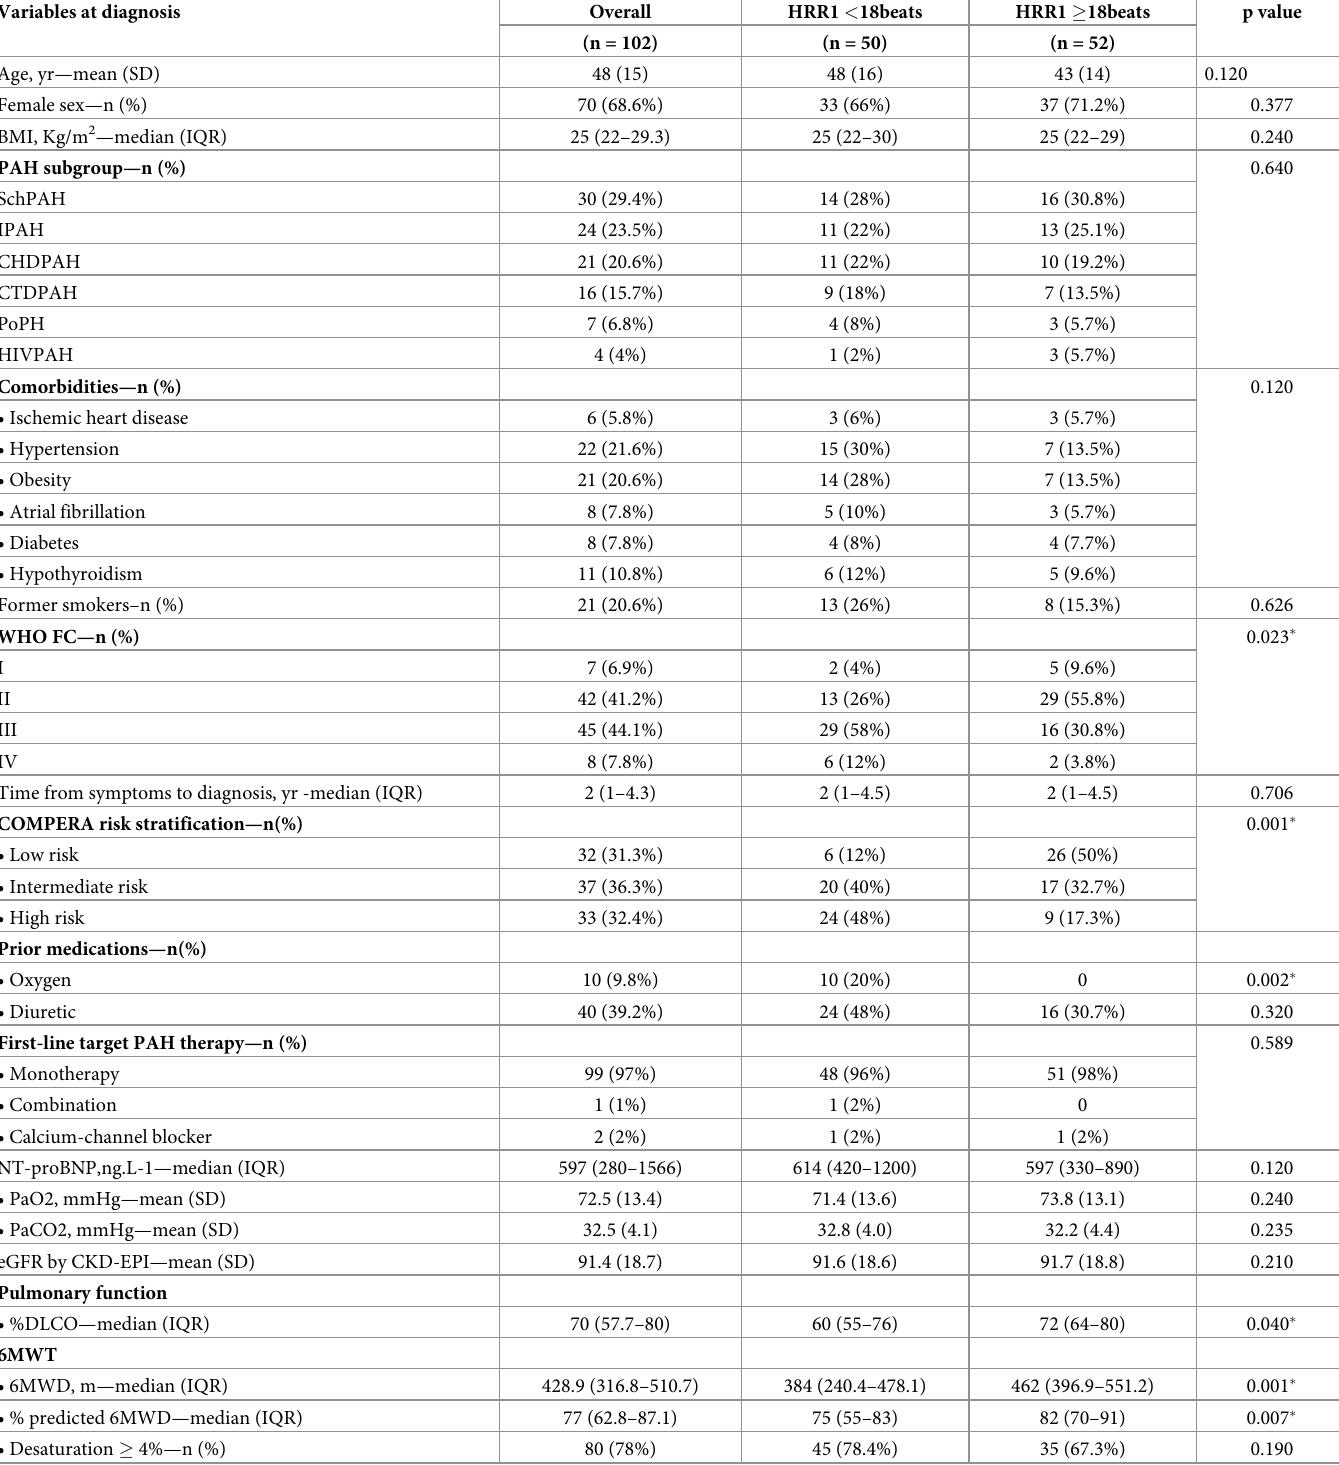
Table 1. Baseline characteristics of pulmonary arterial hypertension patients with heart rate recovery in 1 minute after the end of the 6-minute walk test < or � 18 beats at diagnosis. Variables at